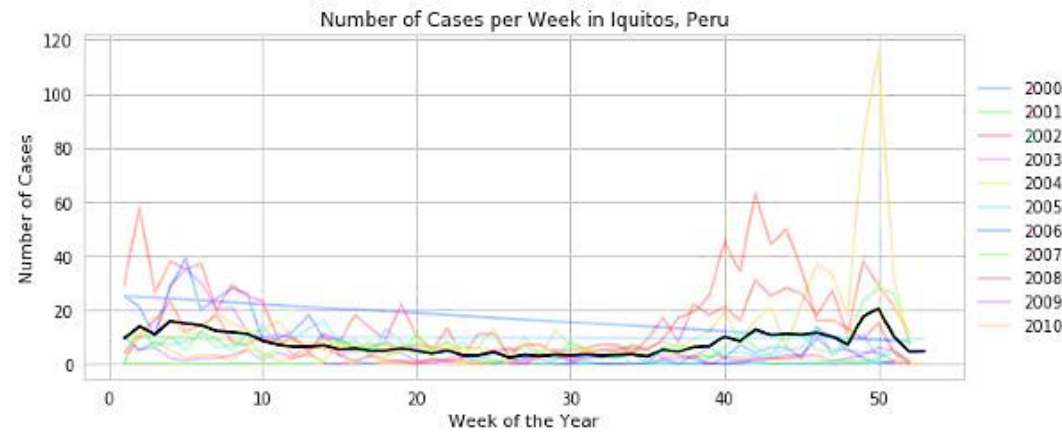
Figure 8. Increase in outbreaks and cases in San Juan city of Puerto Rico in weeks.